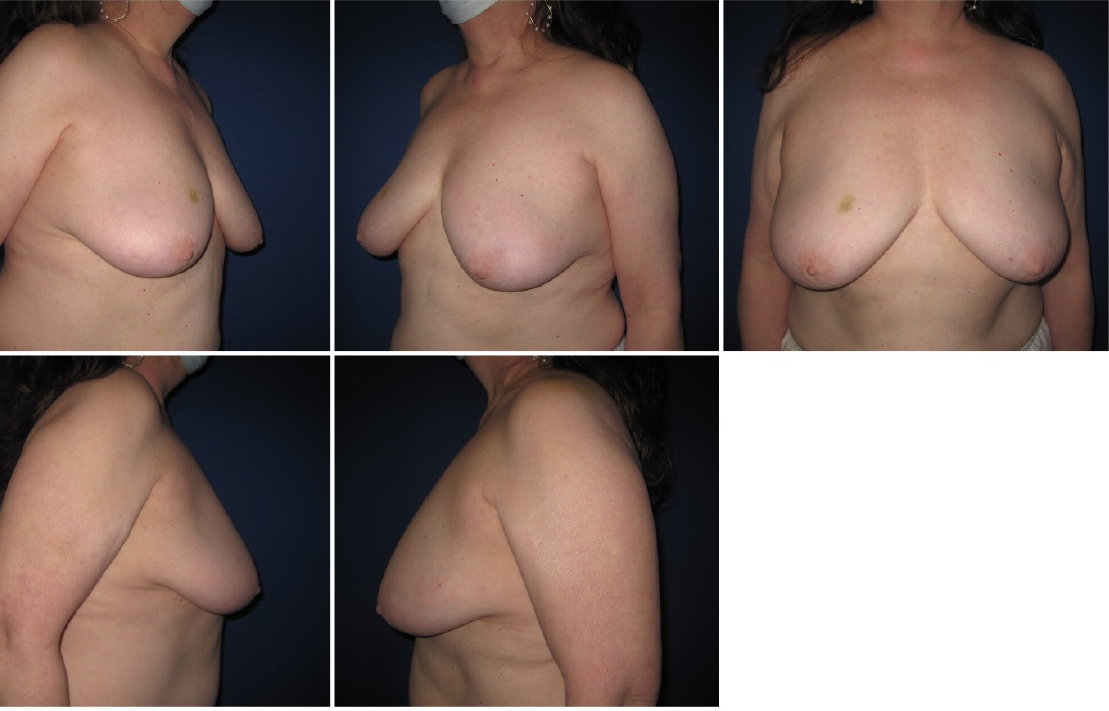
Figure 1. Pre-operative